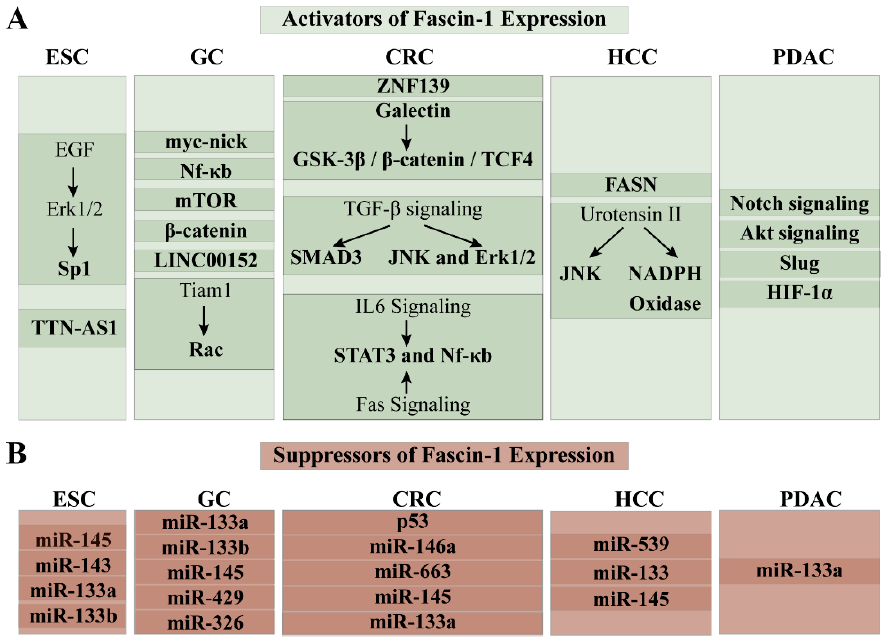
Figure 5. Regulators of the fascin-1 expression in GI tract cancers. ( A ) Factors that elicit upregulation of fascin-1 expression; ( B ) Factors that elicit downregulation of fascin-1 expression.